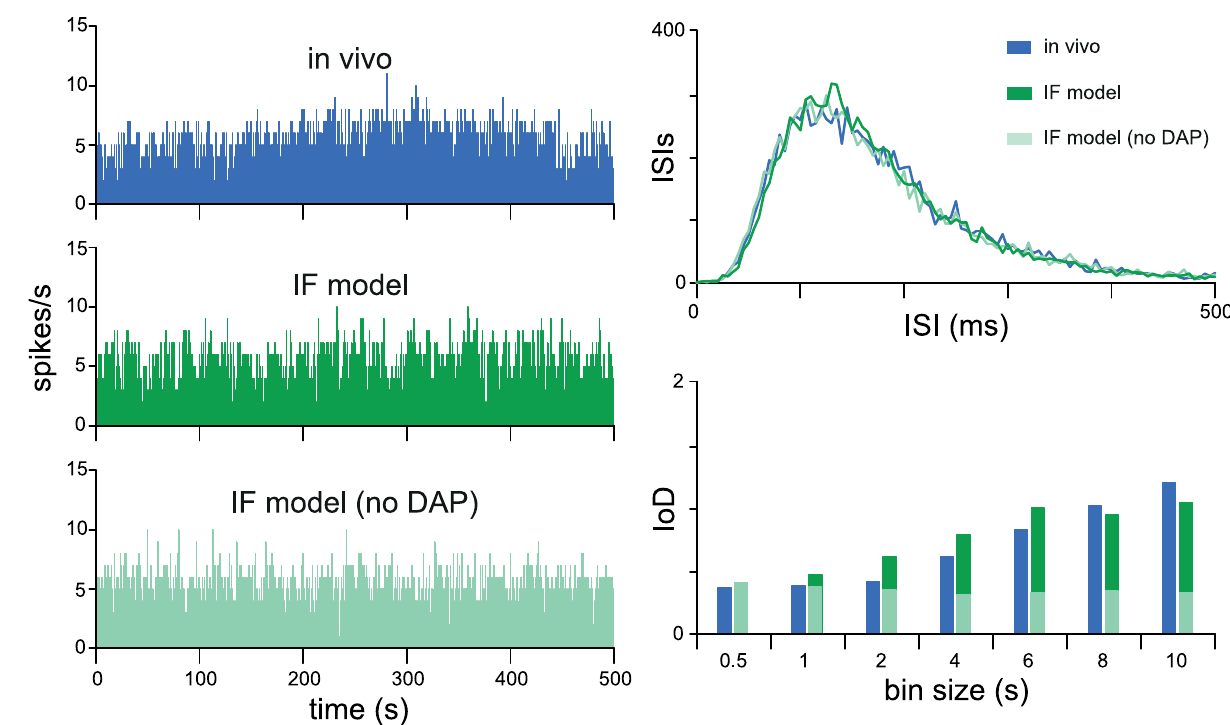
Fig 4. Using a DAP to fit an increasing IoD range. Noise or variability in the spike rate is measured using the IoD. The presence of a large AHP results in a decreasing IoD range, where variability is less at larger binwidths [21]. An increasing IoD range can be mimicked either by a highly variable input signal, or by the amplification of variability due to the action of a DAP. The green in vivo example here is a “random” type cell which shows an increasing IoD range. The ISI distribution can be closely matched by a model neuron with only an HAP (red data), but to also fit the increasing IoD range requires a model neuron with a DAP as well as an HAP (blue